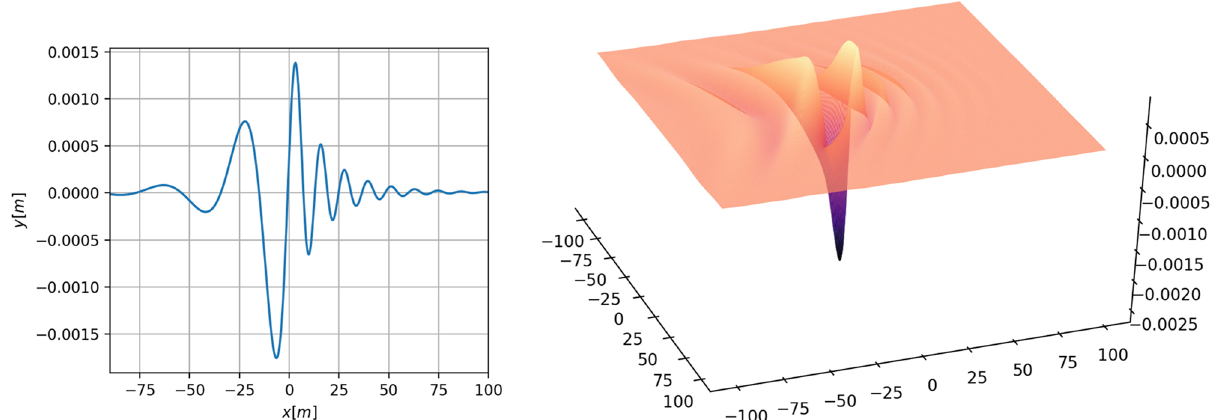
7 m/s. The critical speed in this Figure 1. Hydro-elastic wave response to a load traveling at a velocity v = 5.94 m/s. The left panel shows the central line of the graph in the right panel. At the time shown situation is v c = 0 . The depth is H 6.8 m, thickness of the ice sheet is h in this figure, the load is positioned at x = = 5.1 10 8 N/m 2 . The fluid density is 1026 kg/m 3 , and the ice density is 917 kg/m 3 and the Young modulus is E = ×